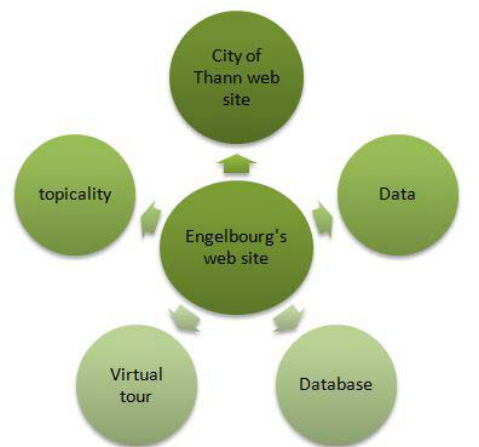
Figure 10. First architecture of information system